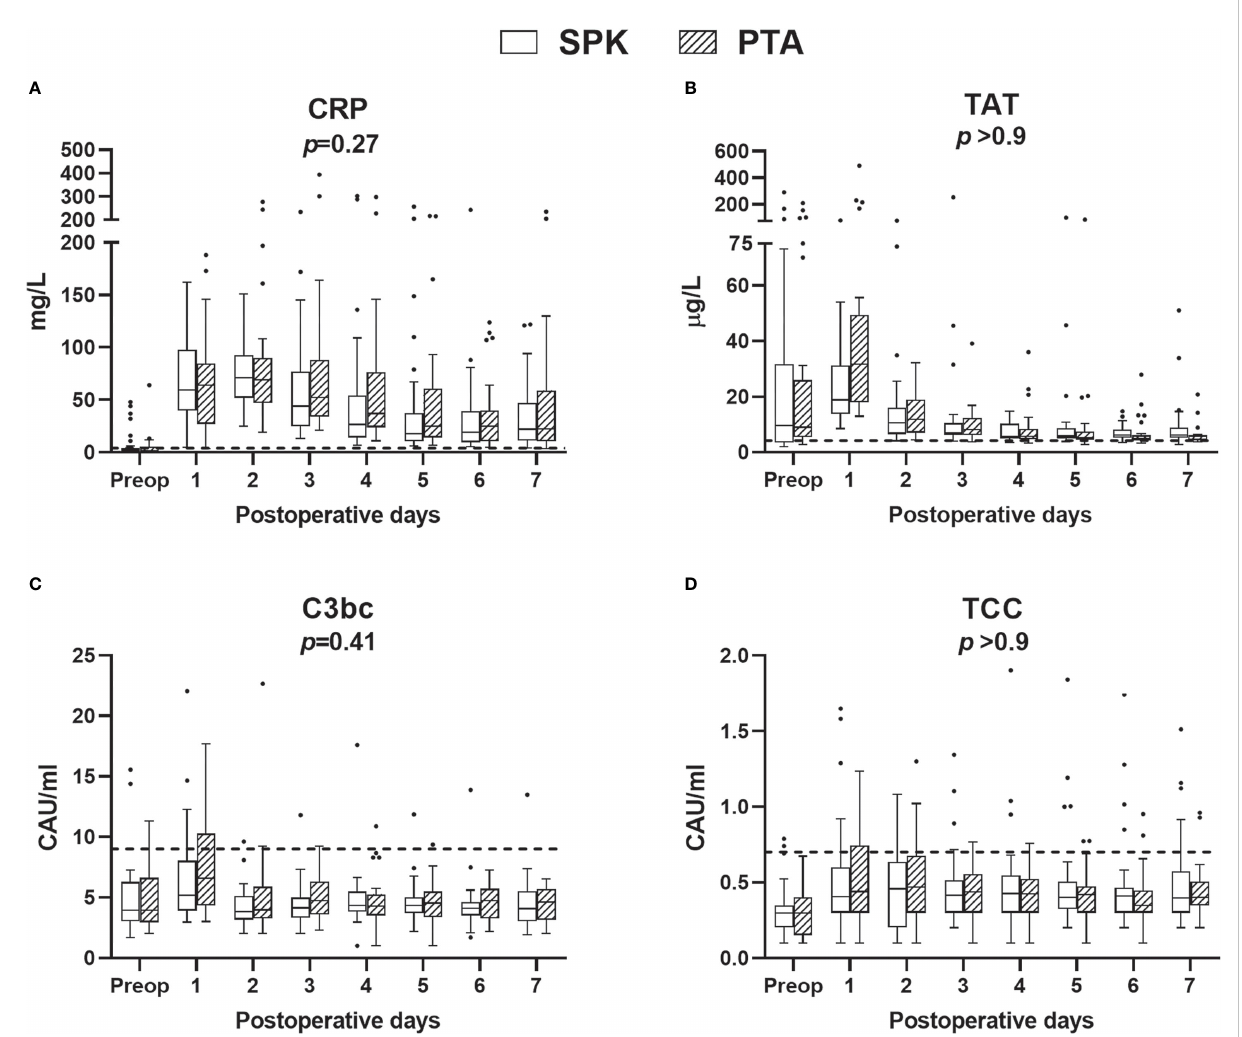
FIGURE 2 Plasma concentrations of C-reactive protein (CRP) (A) , coagulation (B) , and complement markers (C, D) , preoperatively (preop) and during the fi rst postoperative week, for simultaneous pancreas-kidney transplantation (SPK) (n=35) and pancreas transplant alone (PTA) (n=32) patients. Data are presented as boxplots (line, median; box, interquartile range) with whiskers (25 th and 75 th percentiles -/+ 1.5 x interquartile range). Dashed lines represent upper reference limits de fi ned previously in samples from healthy blood donors and are given for reference only. Two outliers are not shown, C3bc value 34 and TCC value 3.8, in PTA patients on postoperative day 1. P -values represent the-postoperative overall group effect (Wald Chi-Squared test), excluding the preoperative samples, in a linear mixed model. CAU, complement arbitrary unit; CRP, C-reactive protein;